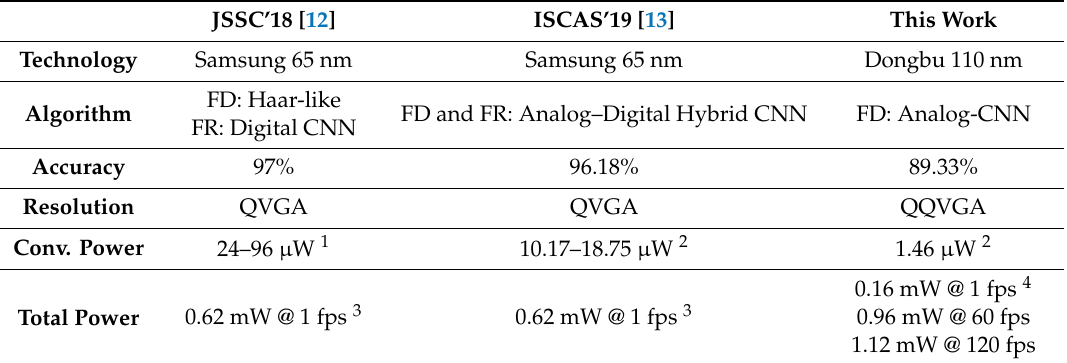
Table 3. Performance